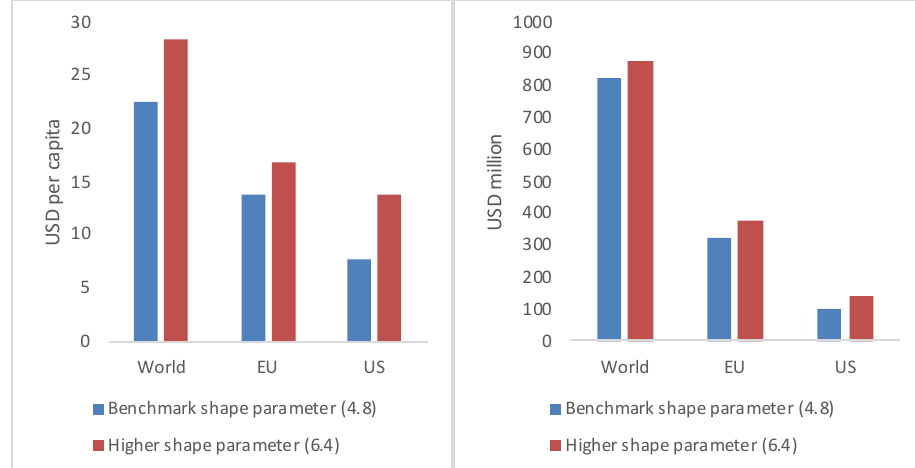
Figure 5. Change in welfare [Equivalent variant per capita in constant USD] and export volumes [Mil- lion constant USD] under different shape parameters of the Pareto distribution of firm productivity.